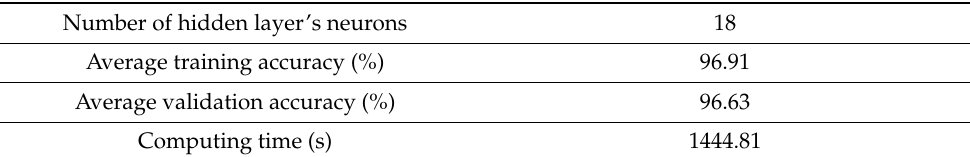
Table 13. Overall statistics of MISO ANN model for diameter prediction.